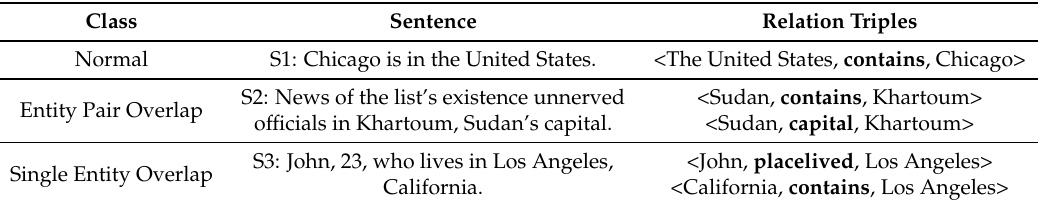
Table 1. Examples of three classes: Normal, Entity Pair Overlap, and Single Entity Overlap. S1 belongs to Normal class because there are no overlaps in its triplets; S2 belongs to Entity Pair Overlap class since the entity pair (Sudan, Khartoum) are overlapped; S3 belongs to Single Entity Overlap class because the entity Los Angeles is overlapped and its two triplets have no overlapped entity